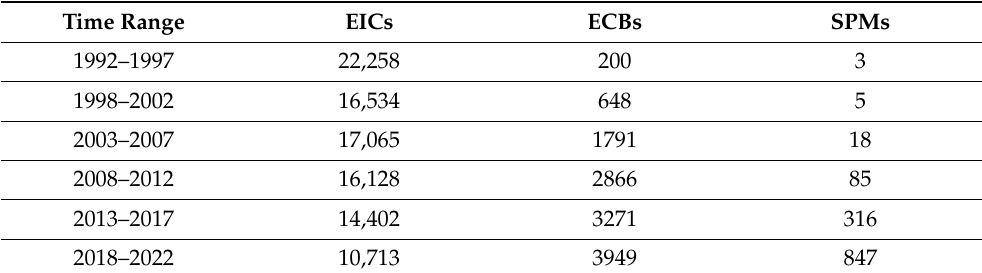
Table 1. Number of entries of a PubMed search with “eicosanoids”, “endocannabinoids” and “specialized pro-resolving mediators” over the last 30